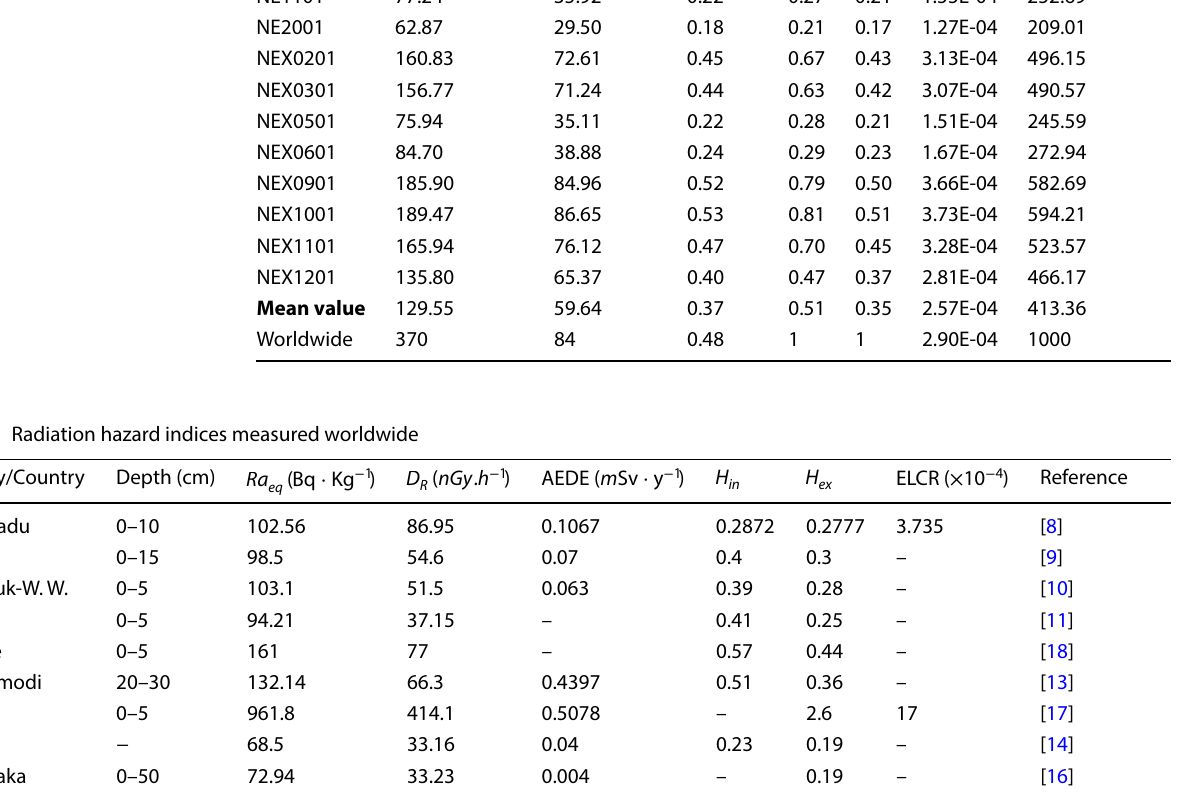
Table 4 Radiation hazard indices of soil from the Northeastern Burkina Faso